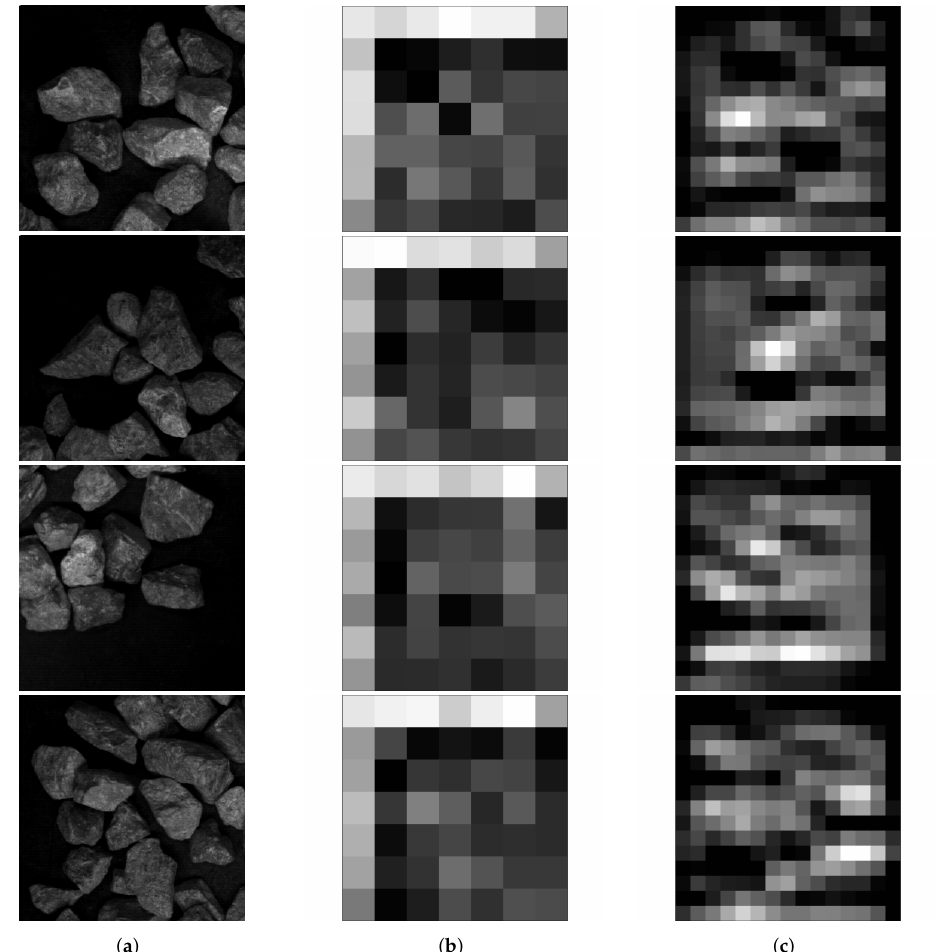
Figure 6. ( a ) Input images. ( b ) The feature maps output from the original detection head. ( c ) The feature maps output from our optimized detection